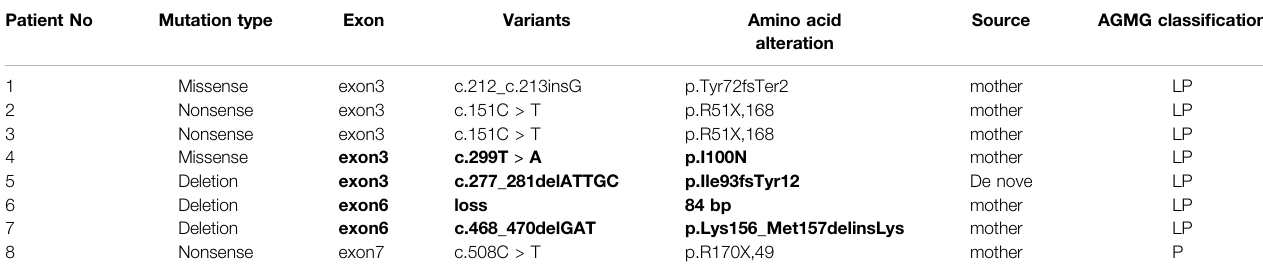
TABLE 2 | Molecular analysis of the HPRT1 gene in 8 Chinese patients from 8 unrelated families with LND. Patient No